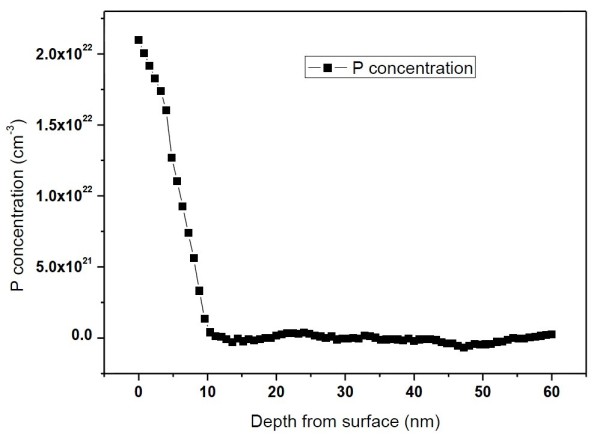
P atom distribution in the surface of polished wafer under low-temperature doping.